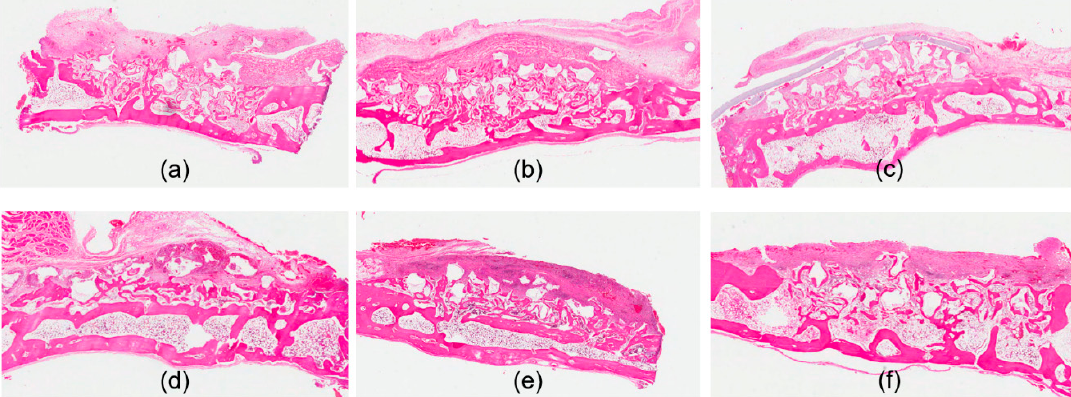
Figure 3. Histological images with hematoxylin and eosin stain. ( a ) Bone graft with no membrane at 2 weeks. New bone formation level is below the adjacent bone margin, and there is soft tissue invasion; ( b ) bone graft with the collagen membrane at 2 weeks. Elevated bone level is noted with the collagen membrane; ( c ) bone graft with the GEL / TSG film at 2 weeks. Presence of the GEL / TSG film and elevated bone level is observed; ( d ) bone graft with no membrane at 4 weeks. Thickened connective tissue over newly formed bone is observed; ( e ) bone graft with the collagen membrane at 4 weeks. Degeneration of the membrane and more advanced maturation of newly formed bone are observed; ( f ) bone graft with the GEL / TSG film at 4 weeks. Maturation of newly formed bone is observed. Degeneration of the film is noted.